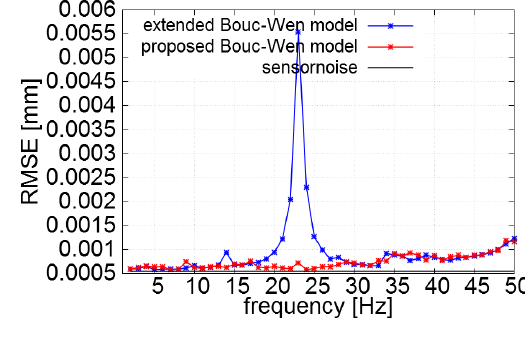
Figure 16. The root mean squared error (RMSE) of compensation as a function of the input frequency.